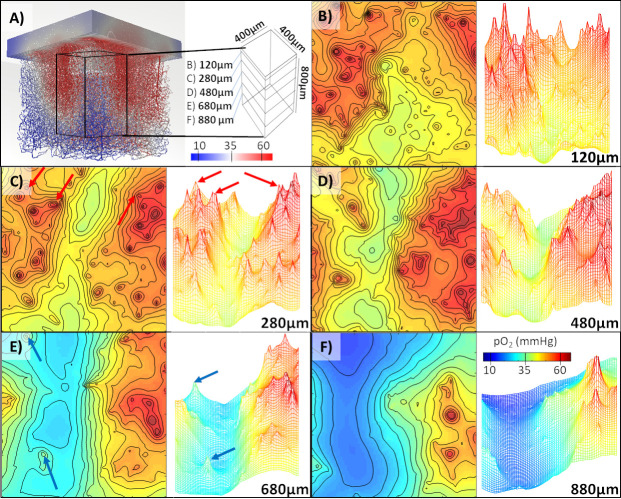
Oxygen distribution throughout a microvascular network specimen (E4.1) from the vibrissa primary sensory cortex in mouse.A) Visualization of a portion of the extravascular space with a block cutout defined by 5 observation planes at different cortical depths (120, 280, 480, 680, and 880μm below the cortical surface). Color coding corresponds to oxygen tension in blood vessels. B-F) The visualization of oxygen distribution at the individual layers. C) Steep oxygen gradients form around penetrating arterioles–marked with red arrows. E) Oxygen tension is also elevated around veins–marked with blue arrows. In the deeper regions E-F) a hypoxic valley begins to form seen as deep blue basins.